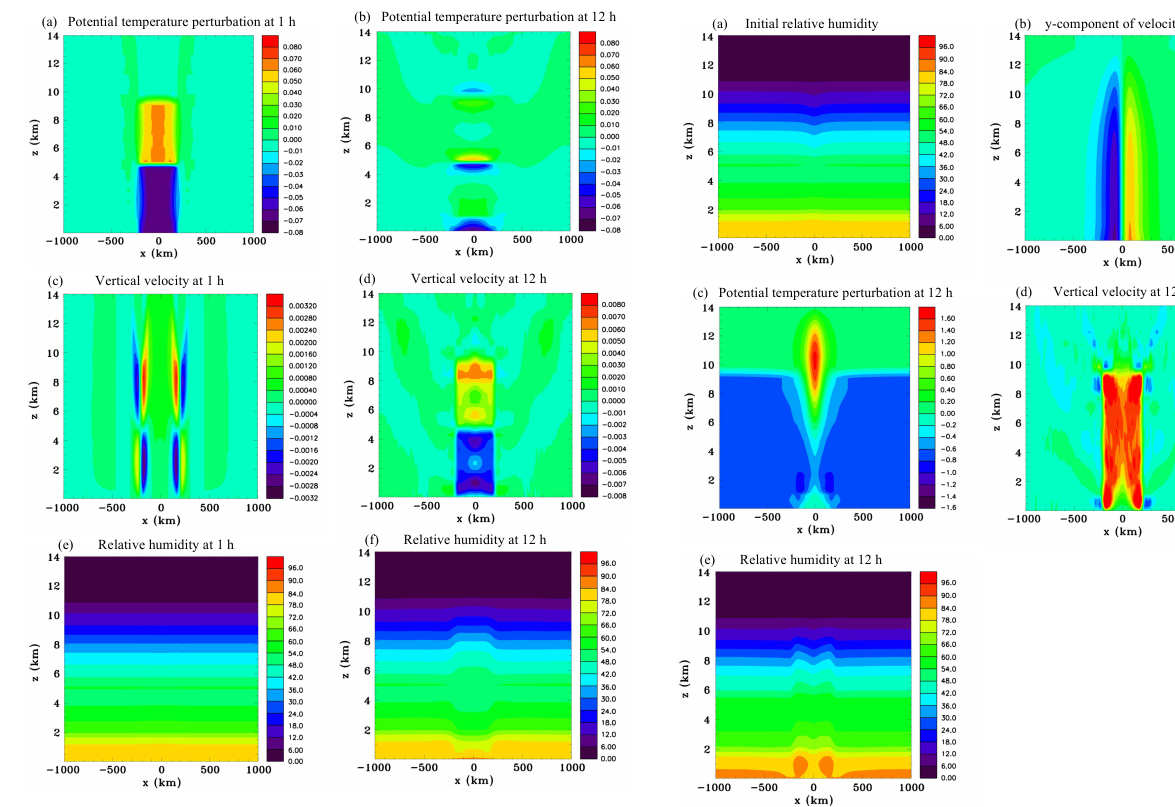
Figure 11. Vertical sections for Experiment 9: the weak vortex case. (a) Relative humidity at t = 0h, (b) y -component of velocity, v at t = 12h (ms − 1 ), (c) potential temperature perturbation at t = 12h (K), (d) vertical velocity at t = 12h (ms − 1 ), and (e) relative humid- ity at t =